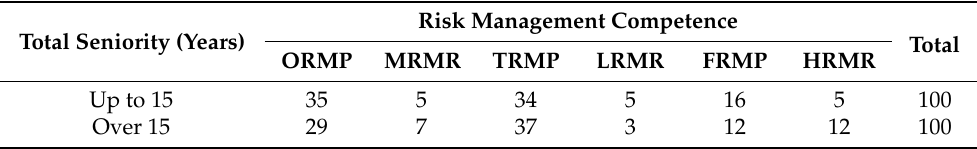
Abbreviations are as defined in Table 1.